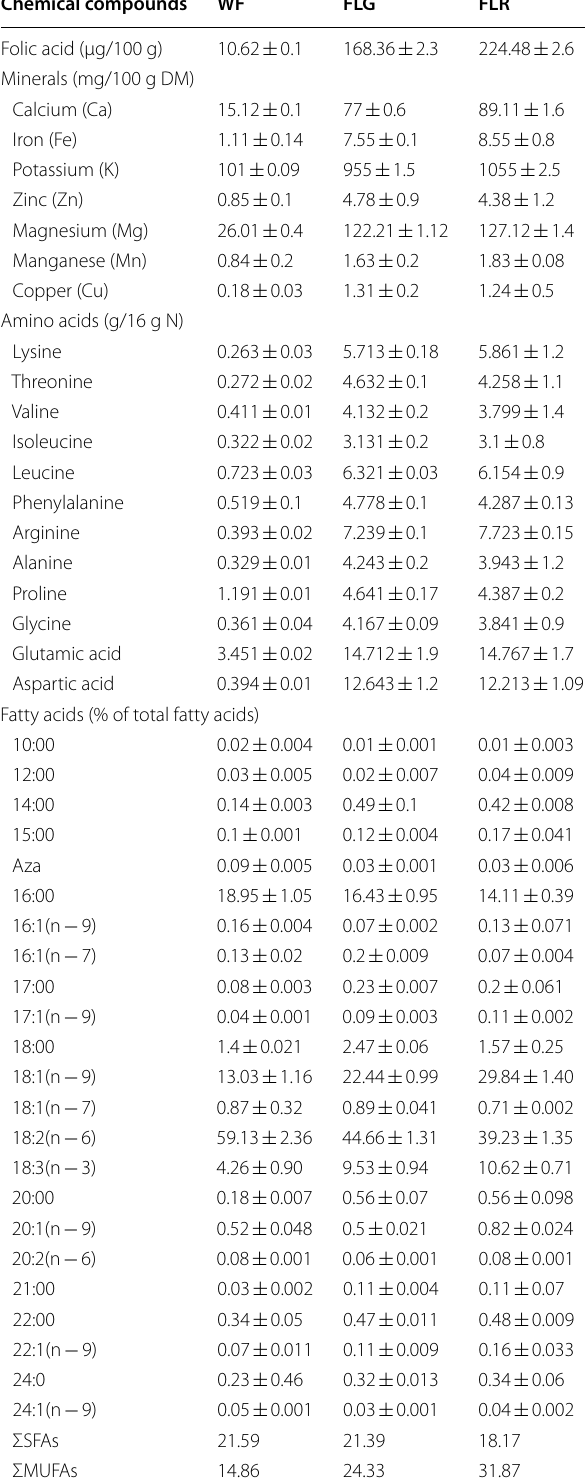
Table 1 Folic acid, minerals, amino acids and fatty acids content in wheat flour (WF), green lentil flour (FLG) and red lentil flour